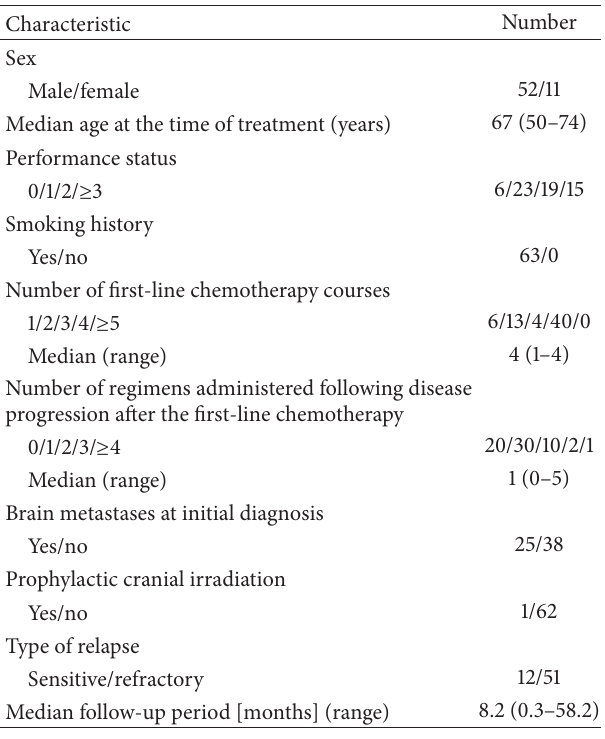
Table 1: Baseline patient characteristics.